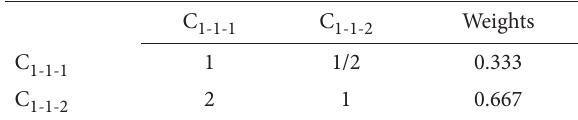
Table 5. Pairwise comparison matrix for Traffic related factors and their weighs